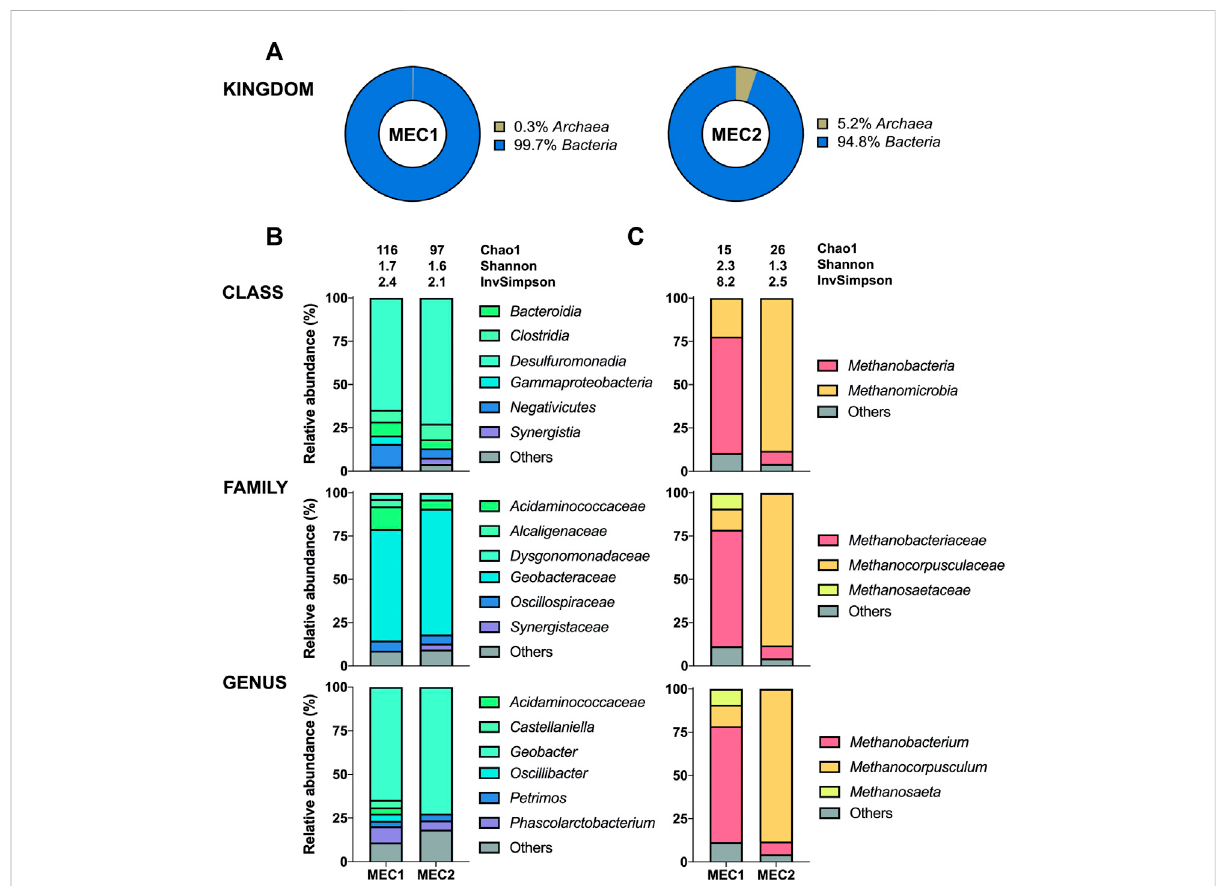
FIGURE 5 The enriched microbial communities of anodic bio fi lms in MECs. (A) Representation of prokaryotes determined by the 16S sequencing. Taxonomic pro fi les of bacteria (B) and methanogenic archaea (C) were set at the class, family, and genus ranks. Bacterial representation was determined by the 16S sequencing and methanogenic archaea by the mcrA sequencing. Only representatives with a relative abundance > 3% in at least one condition are shown. Alpha diversity was estimated by the following indices: Chao1, Shannon, and Inverse Simpson. Detailed information is given in Supplementary Table